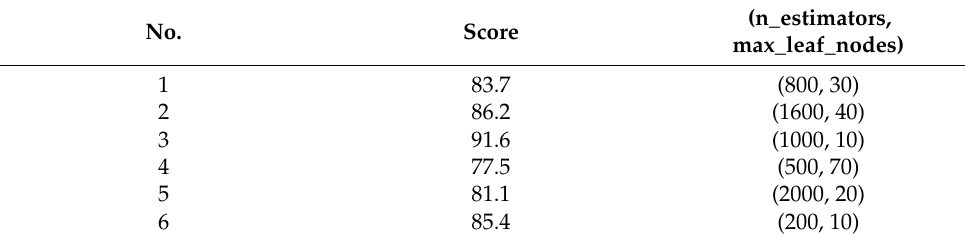
Table 4. Scores of each hyperparameter group obtained by manual